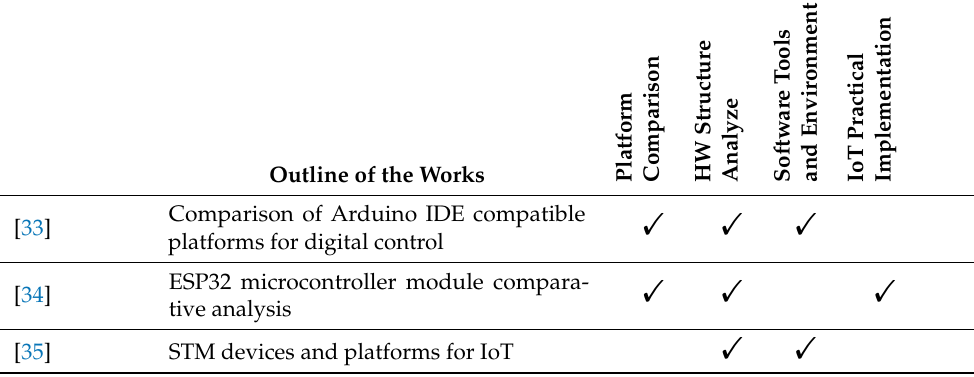
Table 2. This table contains an overview of articles dealing with microcontrollers and the development platforms.